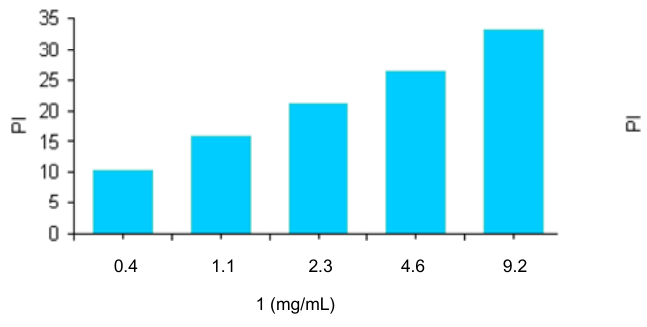
Figure 2. Scavenging effects of antioxidant polymers on the DPPH free radical. The results represent means ± SEM of three